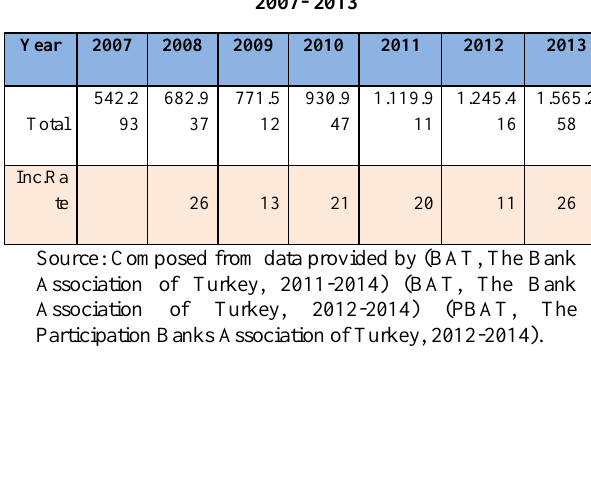
Table-18: The Shares of Participation Banks within the